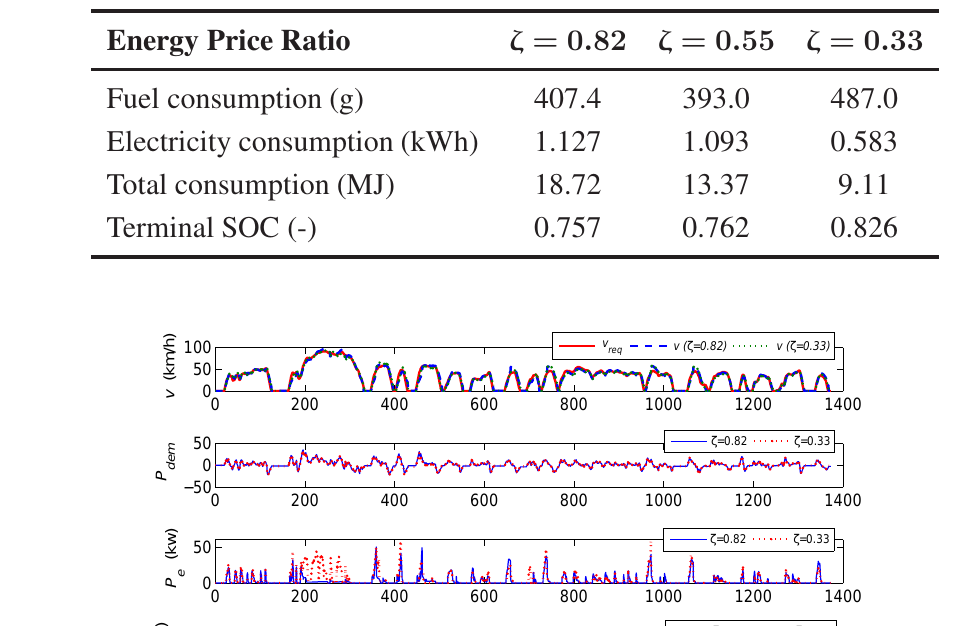
Table 4. Comparison of the energy cost for the MBOC strategy in ζ = 0 . 82 , ζ = 0 . 55 and ζ = 0 . 33 .